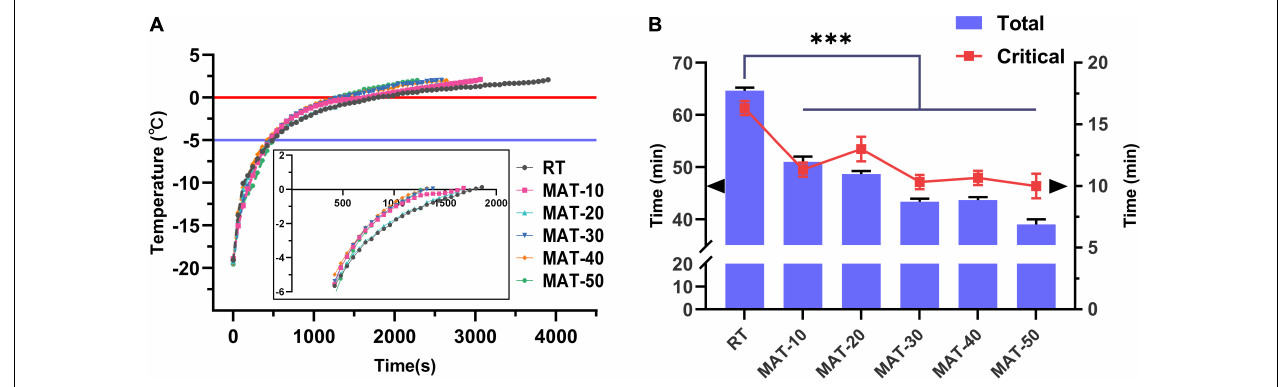
FIGURE 3 | Thawing curves of frozen beef with different thawing treatments. (A) Evolution of temperature at the center of beef samples during RT and MAT thawing experiments. (B) Total thawing time and critical time of frozen beef with different thawing treatments. Critical time, the time of passing the maximum ice crystal formation zone. ∗∗∗ indicates P <